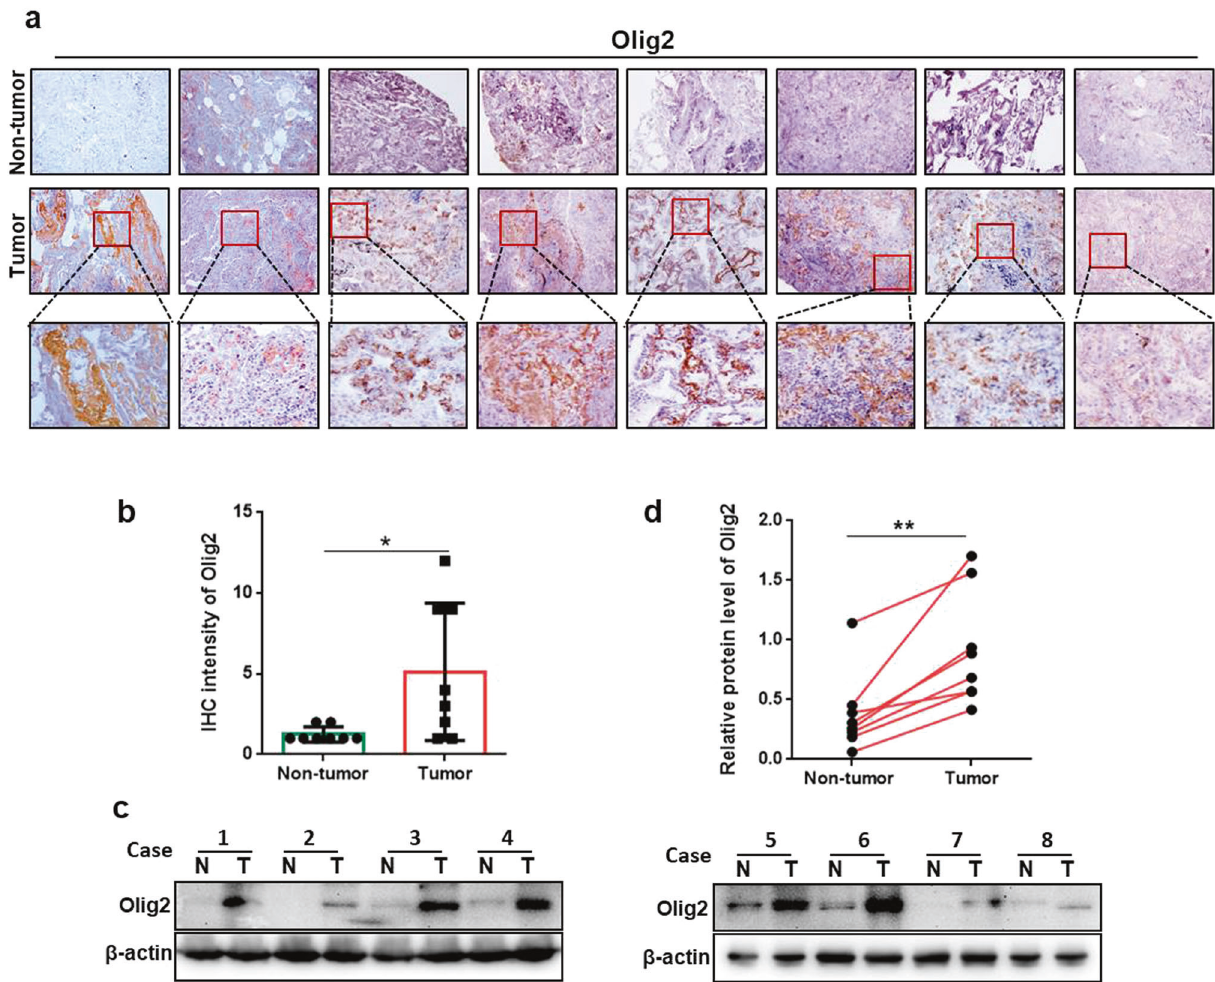
Fig. 1 Olig2 was overexpressed in lung cancer tissues. a The representative pictures of immunohistochemical staining of Olig2 in paraf fi n- embedded human lung cancer tissues and non-lung cancer tissues. b Statistical analysis of Olig2 immunohistochemical staining of lung cancer tissues and non-lung cancer tissues, n = 8. c Western blot analysis of Olig2 expression in lung cancer tissues and non-lung cancer tissues, n = 8. d Statistical analysis of Olig2 expression in lung cancer tissues and non-lung cancer tissues, values were normalized to β -actin, n = 8. The data were presented as the mean ± SD, * p < 0.05, ** p <